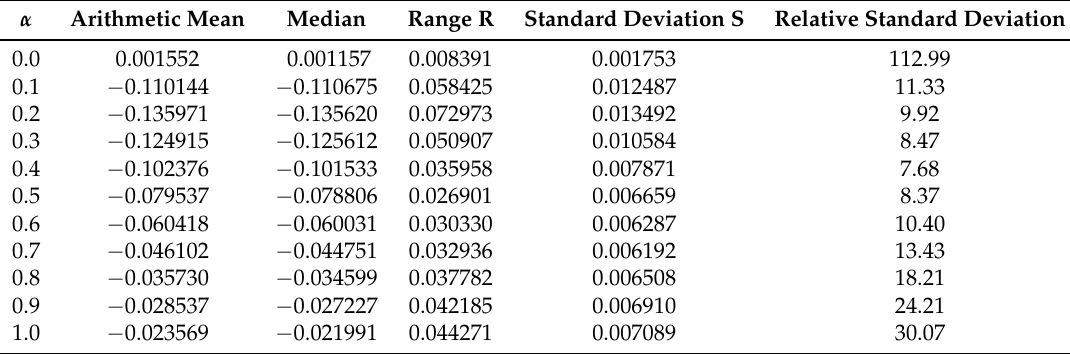
Table 1. Statistical values for the process end